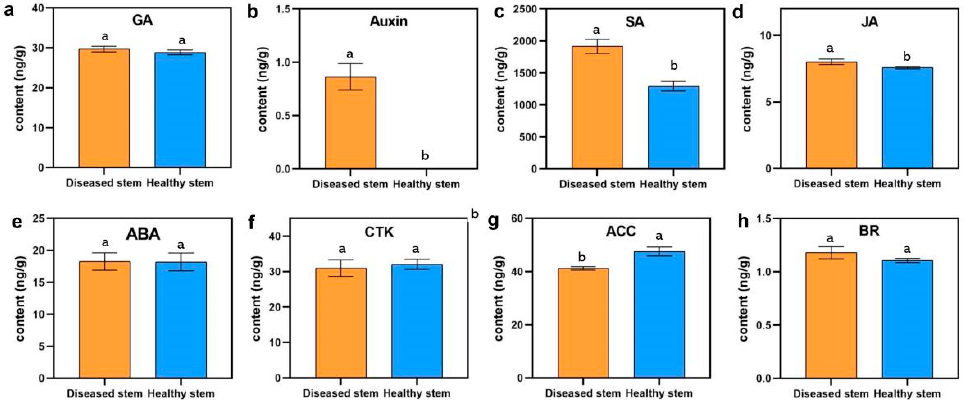
Figure 4. Endogenous plant hormone contents in flat and healthy cucumber stems: ( a ) gibberellin (GA); ( b ) auxin; ( c ) salicylic acid (SA); ( d ) jasmonic acid (JA); ( e ) abscisic acid (ABA); ( f ) cytokinin (CTK); ( g ) 1-aminocyclopropane-1-carboxylic acid (ACC); and ( h ) brassinolide (BR). Different letters represent significant differences in different groups ( p < 0.05, Duncan’ test).